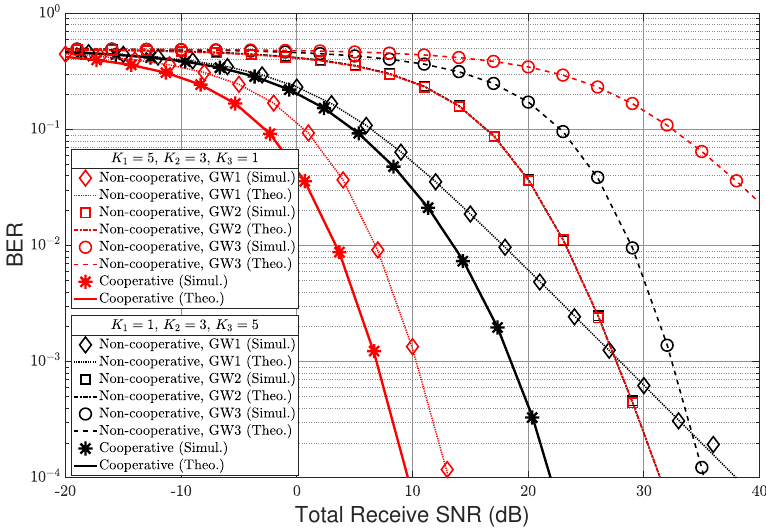
Figure 3. BER performance of LPWAN for varying the total received SNR when N = 3;